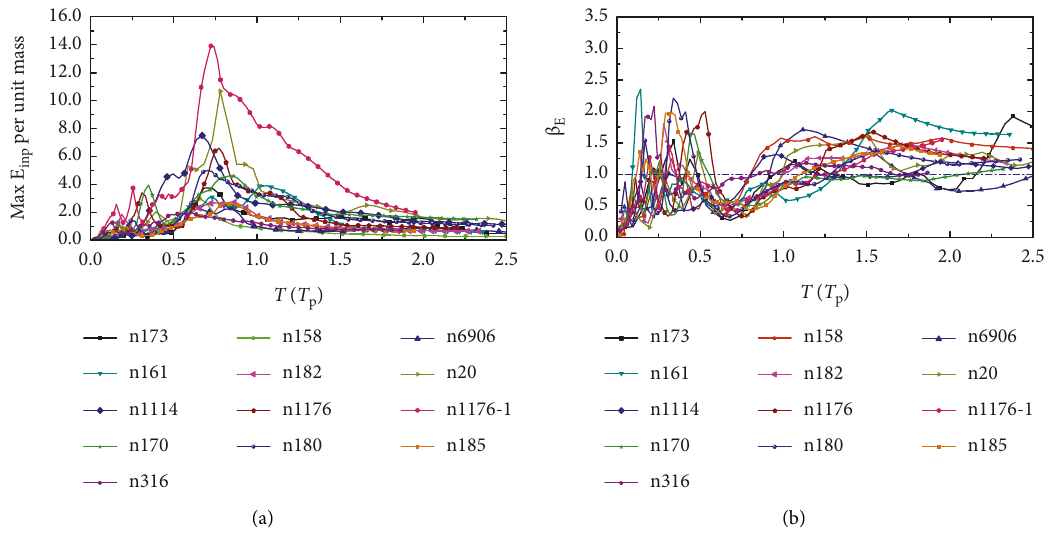
Figure 9: Max seismic input energy of structures subjected to some pulse excitations: (a) uncontrolled structure and (b) structure with VDs.